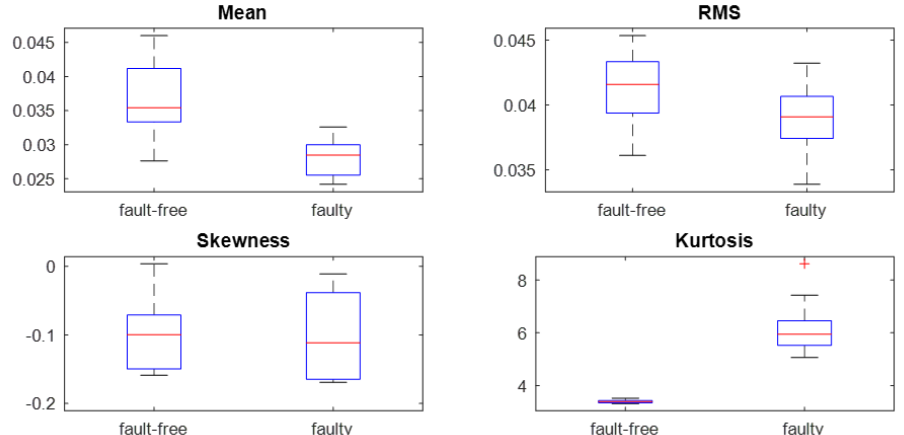
Figure 9. Frequency spectrum of vibration acceleration signal: ( a ) Vertical vibrations for fault-free state, ( b ) Horizontal vibrations for fault-free state, ( c ) Vertical vibrations for faulty state, ( d ) Hori- zontal vibrations for faulty state.